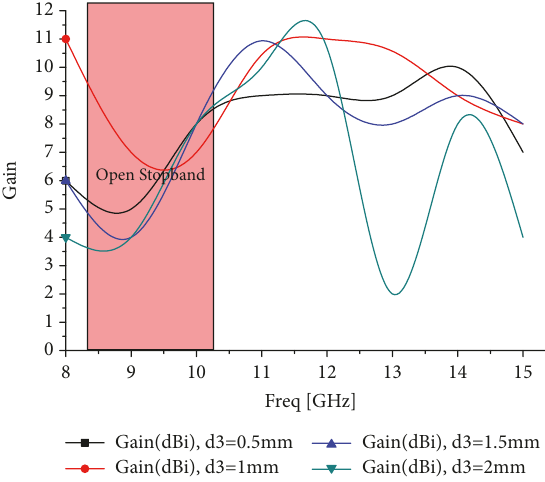
Figure 11: Influence of D3 on proposed antenna gain.